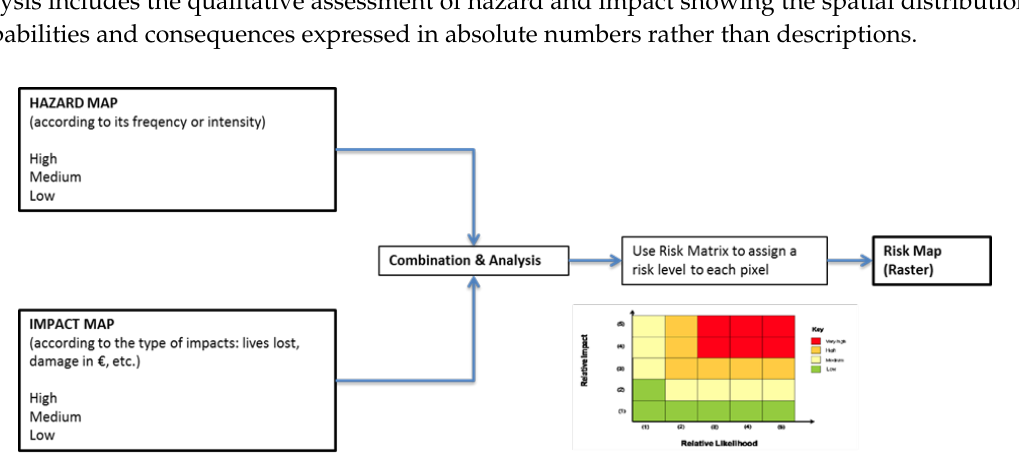
Figure 4. Qualitative risk analysis and mapping procedure [46].